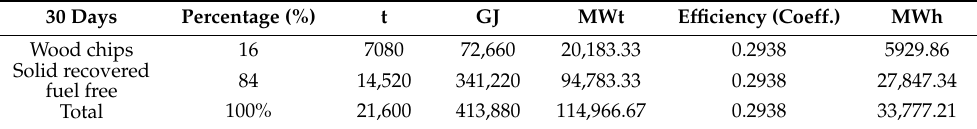
Table 9. Monthly recalculation of operation for solid recovered fuel and wood chips at a ratio of